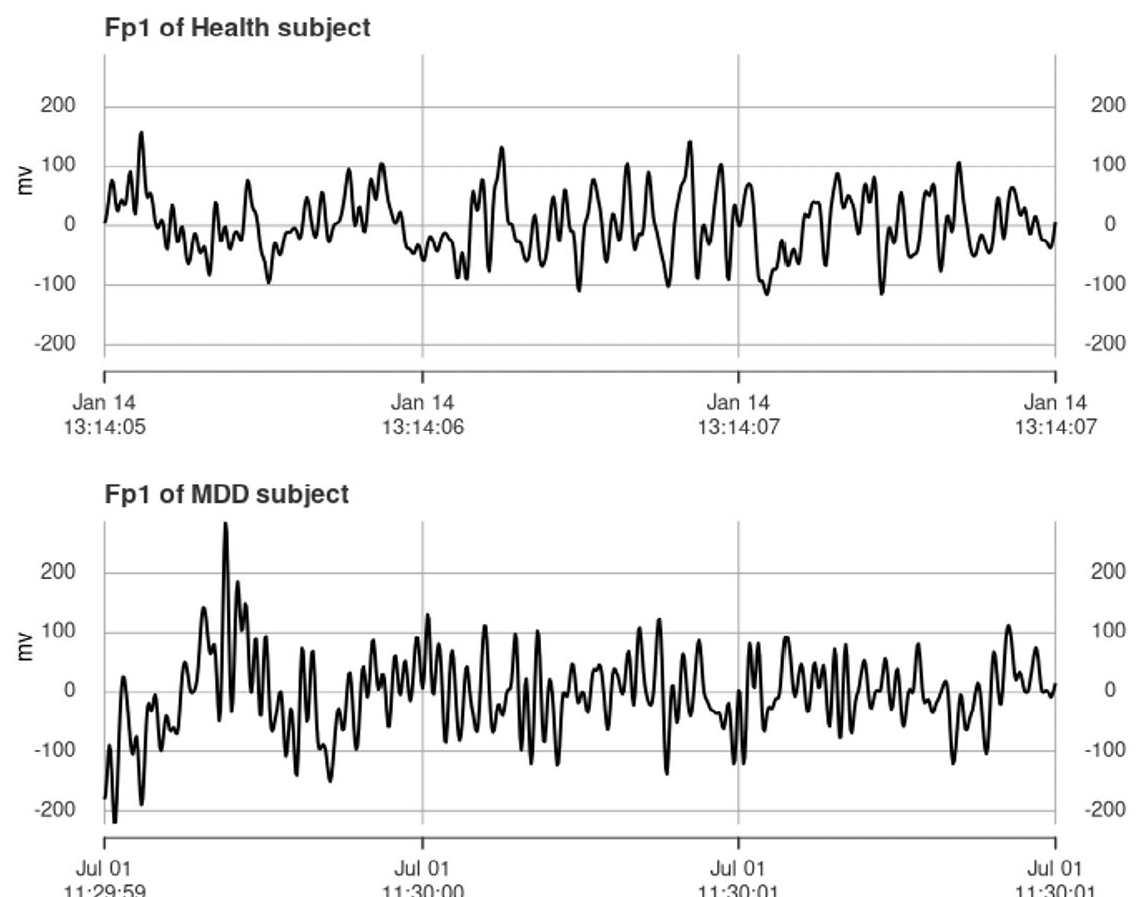
Figure 2. EEG signals of Fp1 channel from two subjects—depressed (MDD) and healthy subject—over about 3 minutes.